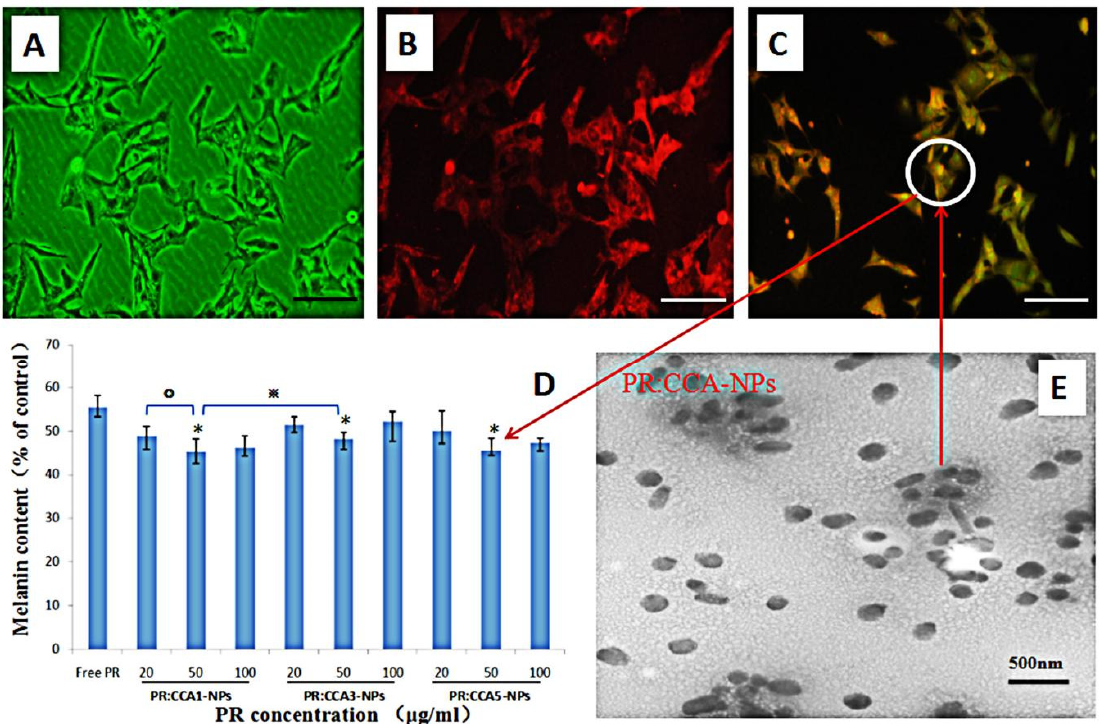
Figure 6. ( A – C ) The FITC labled PR:CCA-NPs were added to B16 cells and co-incubated for 4h to detect the effects of PR: CCA-NPs on pinocytosis by cells, the scale bar represents 25 μ m. ( A ) Control group, ( B ) DiD labeled cell membrane, ( C ) FITC labeled PR:CCA-NPs; ( D ) Effects of different NPs with different concentration on cellular melanin content in B16 cells; E: TEM of PR: CCA5-NPs. Note: * P < 0.05: CCA-NPs (50 μ g/mL) vs Free PR; ※ P < 0.05: CCA1 (50 μ g/mL) vs CCA3 (50 μ g/mL); ° P < 0.05:CCA1 (50 μ g/mL) vs CCA1 (20 μ g/mL).